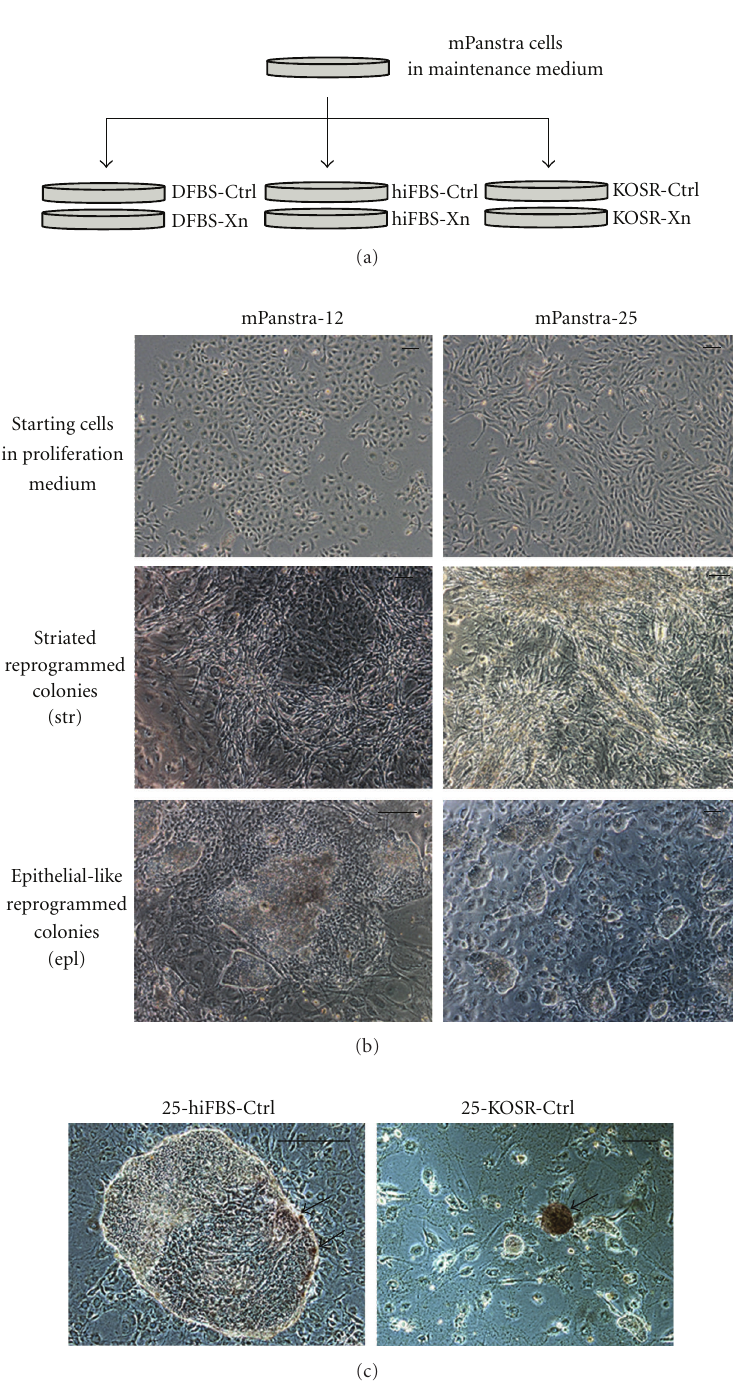
Figure 3: Derivation of reprogrammed colonies by culturing mPanstra cells under pluripotent stem cell culture conditions. (a) mPanstra cells grown in their maintenance medium were transferred to monolayers of STO feeder cells in medium supplemented with dialyzed fetal bovine serum (DFBS), heat-inactivated fetal bovine serum (hiFBS), or KnockOut Serum Replacement (KOSR). Each type of serum supplement was evaluated with (Xn) or without (Ctrl) Xn supplementation. Only SACK-D strains mPanstra-12 and mPanstra-25 formed colonies. (b) SACK-D mPanstra strains (top panel, under routine culture conditions) generate two types of colonies two weeks after transfer into reprogramming conditions: striated (str, middle panels) or epithelial-like (epl, lower panels). (c) A subset of cells from epithelial colonies express alkaline phosphatase (red color, indicated by arrows), a general pluripotency marker. Scale bars = 100 μ